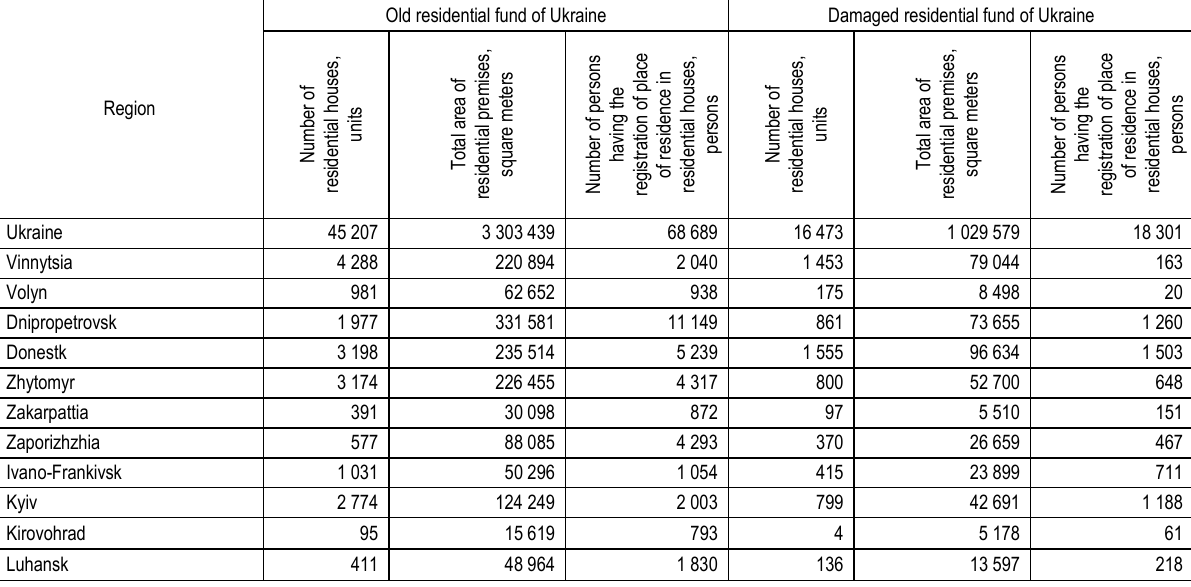
Table 3. Indicators of the state of old and damaged residential premises in Ukraine and its regions in 2016 Old residential fund of Ukraine